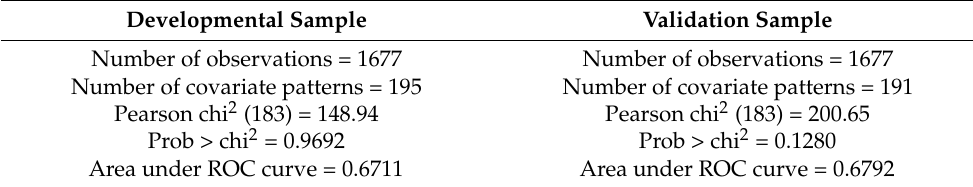
Table 4. Results from calibration tests in the logistic regression